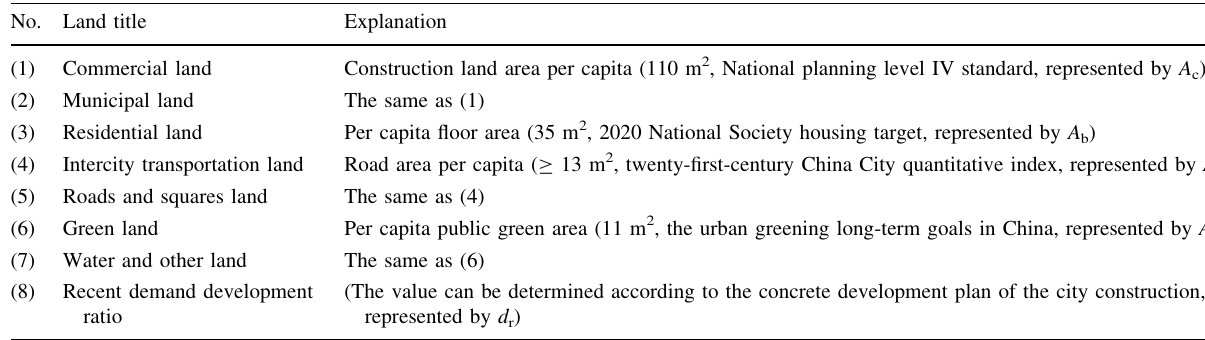
Table 4 Forecasting indicators of station area land types No. Land